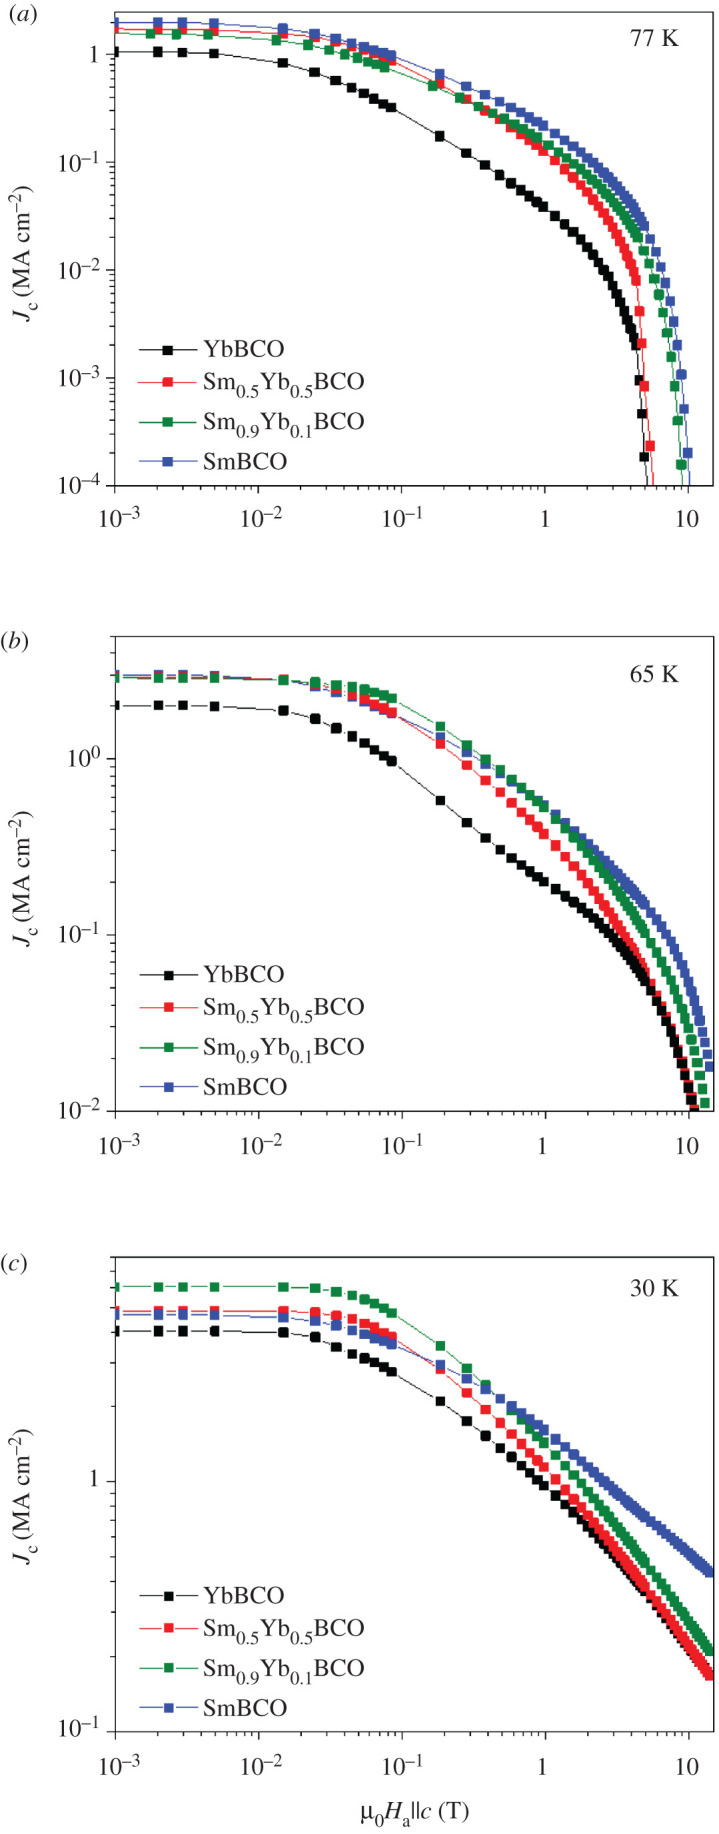
Jc dependence on magnetic field of Yb1−xSmxBa2Cu3O7−δ films at (a) 77, (b) 65 and (c) 30 K.